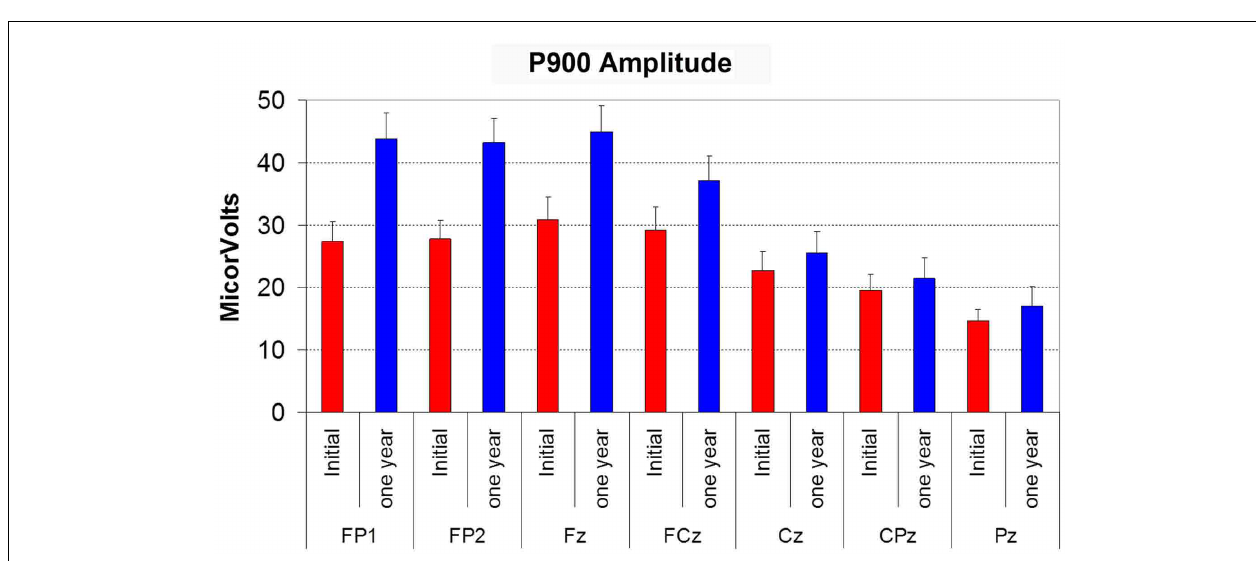
FIGURE 3 | Histogram showing the amplitude of P900 (in microvolts) at initial assessment (red bars) and at 12month follow-up (blue bars) at each electrode site. Error bars reflect